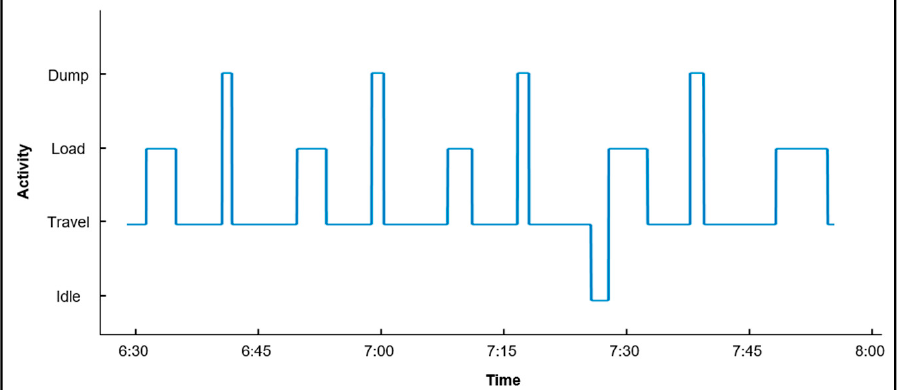
Figure 4. Activity profile of a dump